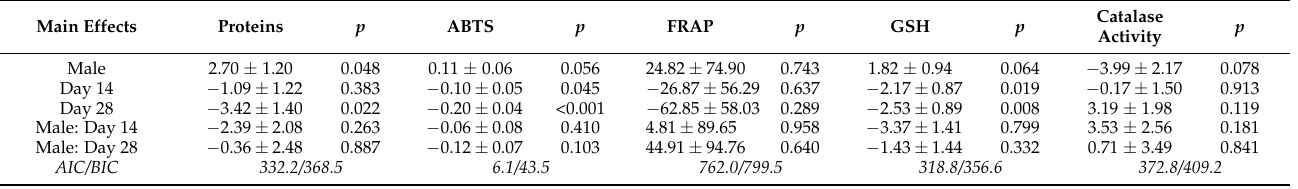
Table 2. Linear mixed models with random effects associated with macronutrients and antioxidants of the breast